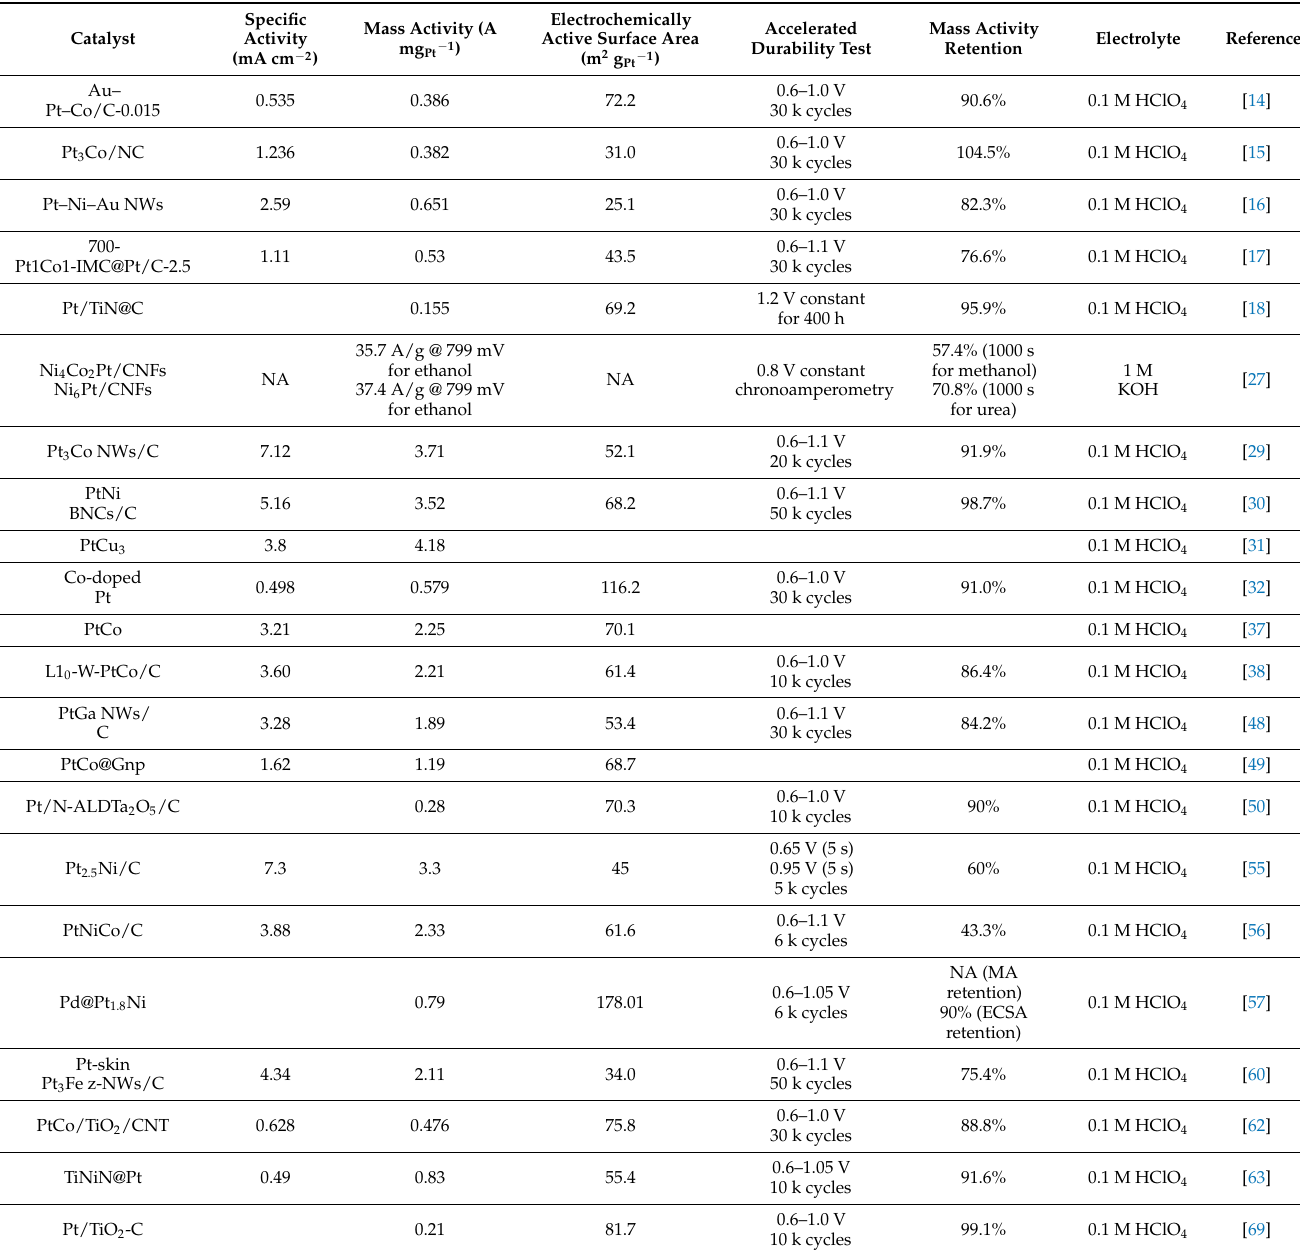
Table 1. ORR performance of catalysts in the relevant